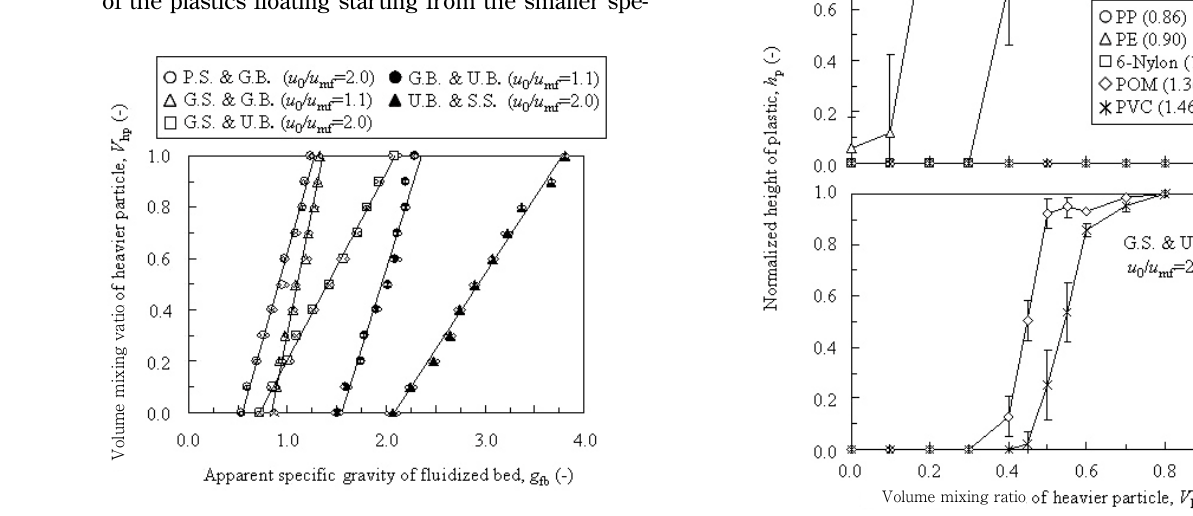
Fig.8 Dependences of normalized height of plastic on volume mixing ratio of heavier particle. (G.B.(150~180 μ m, u mf = 2.9 ± 0.1 cm/s), G.S.(355~425 and 425~500 μ m, u mf = 8.1 ± 0.3 and 11.6 ± 0.3 cm/s), U.B.(180~212 μ m, u mf = 5.9 ± 0.1 cm/ s)).